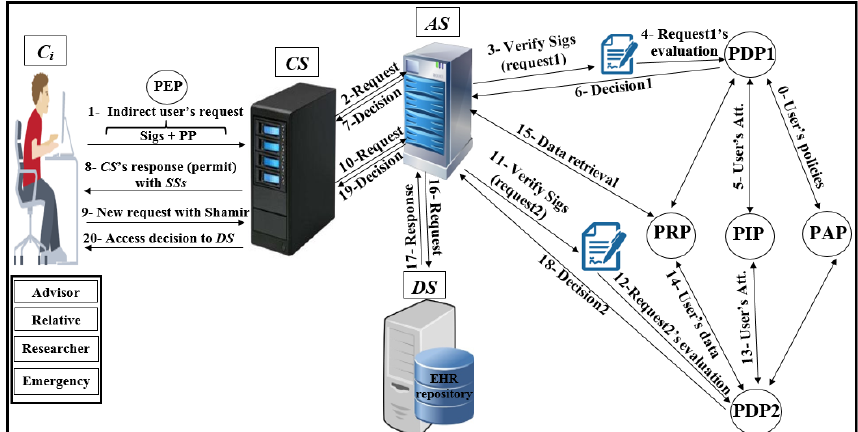
Figure 13. Part of medical records for patients. for patients.